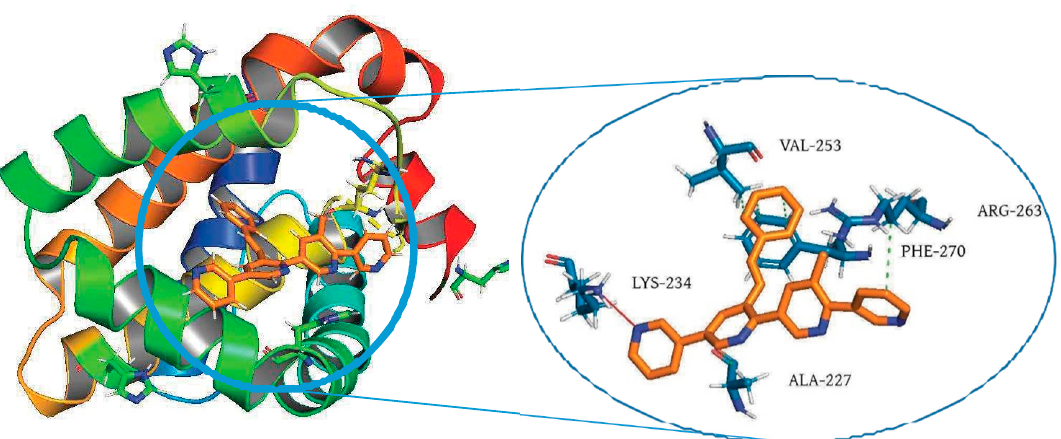
(Left) Pyridoclax (light brown & licorice representation) interacting within the binding groove of Mcl-1 (cartoon representation). (Right): detailed view of Mcl-1 interacting residues: H-bond (solid red) & hyrdrophobic interactions (dashed green) represent the main contribution.